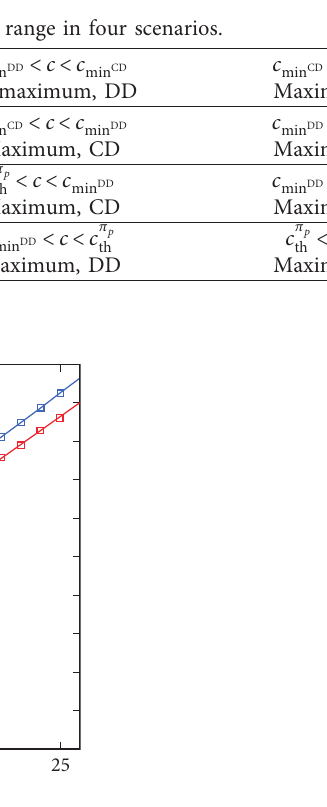
Figure 7: Accumulated profits of the platform operator obtained in systems CD and DD.